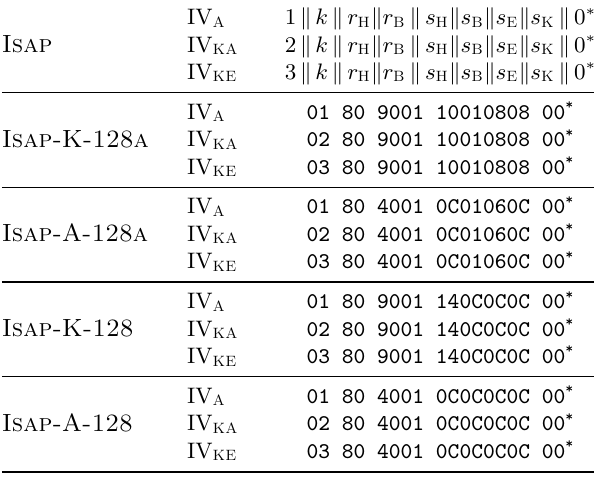
Table 2: Initial values for Isap instances in hex notation.